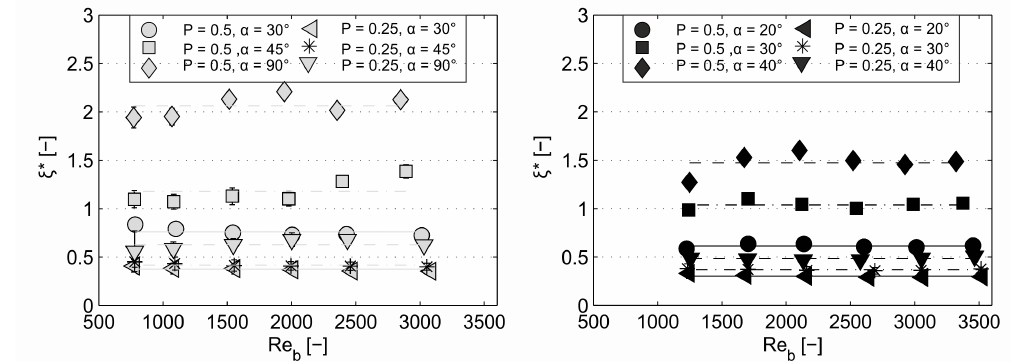
Figure 6. Head loss coefficient ξ ∗ versus Bar–Reynolds number Re b for selected CBTR ( left ) and FFF configurations ( right